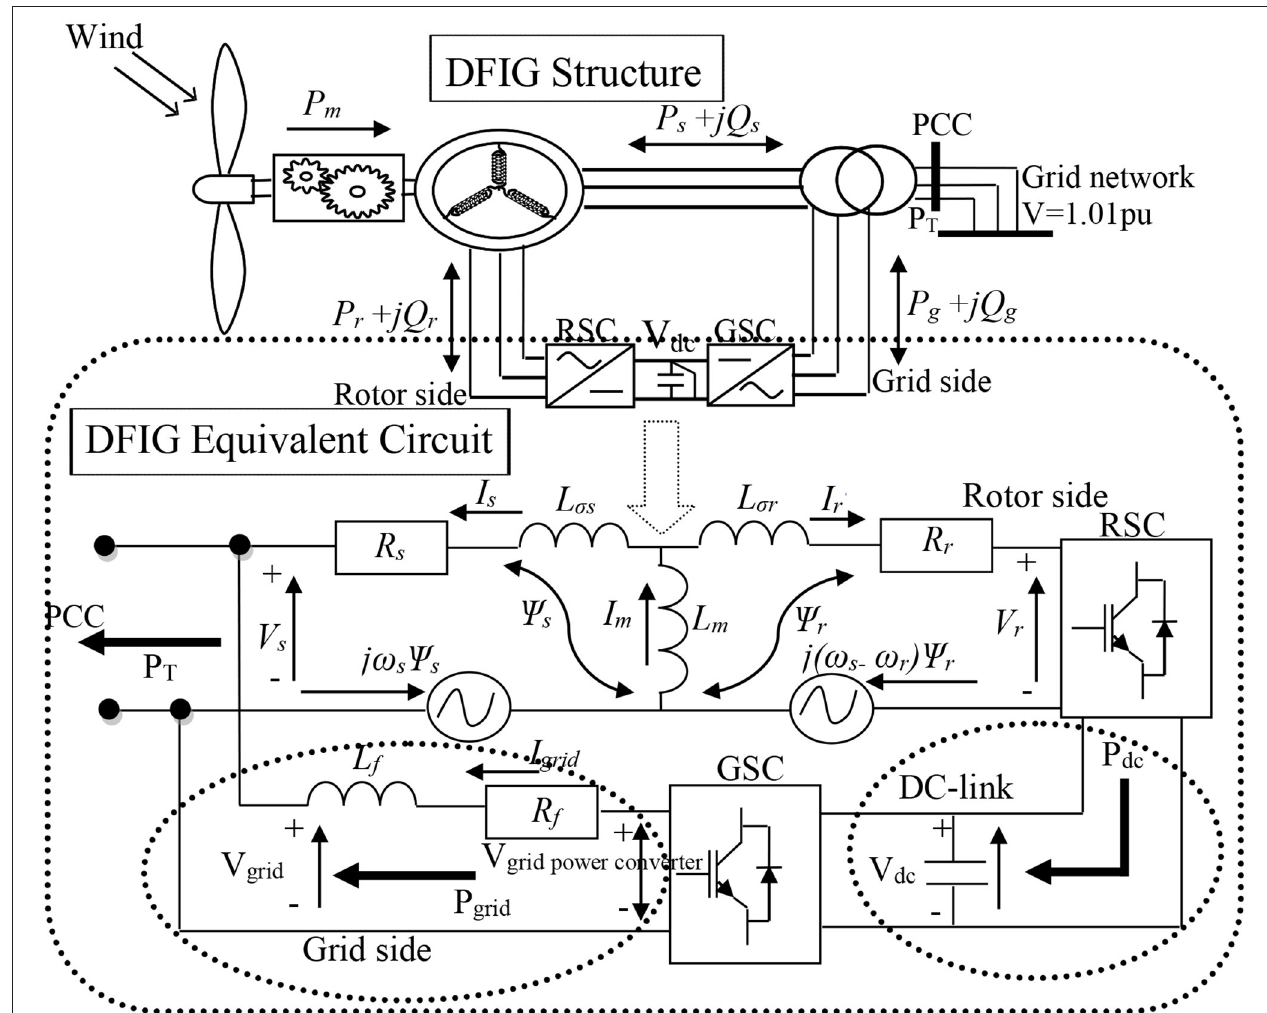
FIGURE 2 | DFIG grid connection